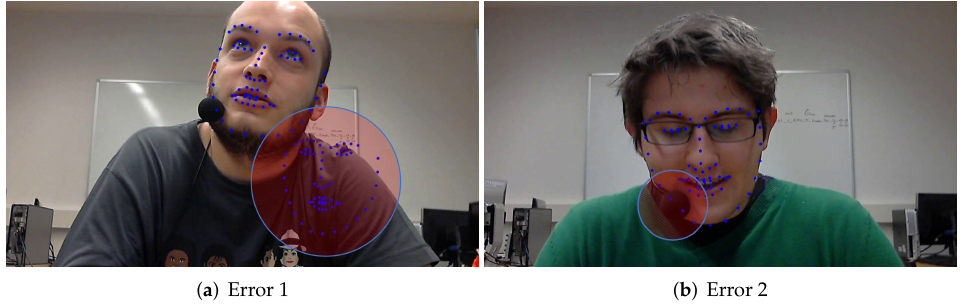
Figure 1. Common errors occurred during facial landmarks extraction, due to ( a ) noisy regions within the input image and ( b ) the attached